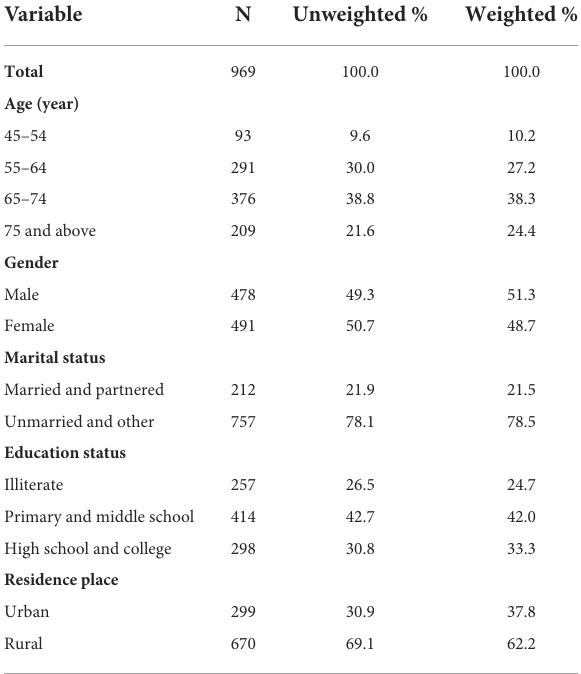
TABLE 1 Characteristics of the individuals with stroke in